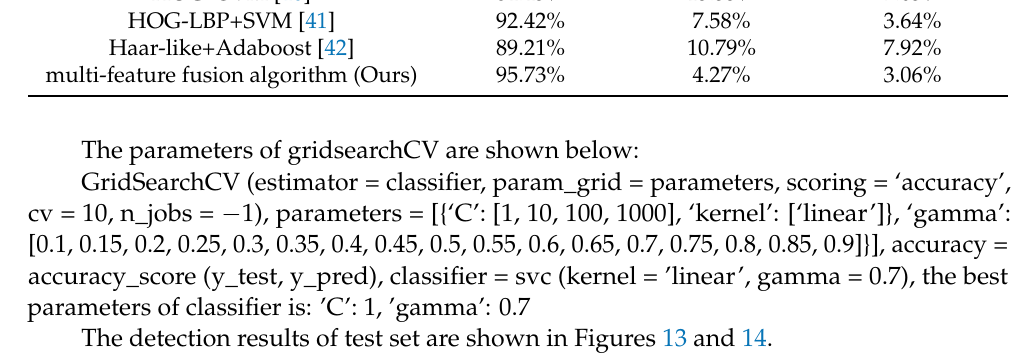
Figure 12. Detection flow.